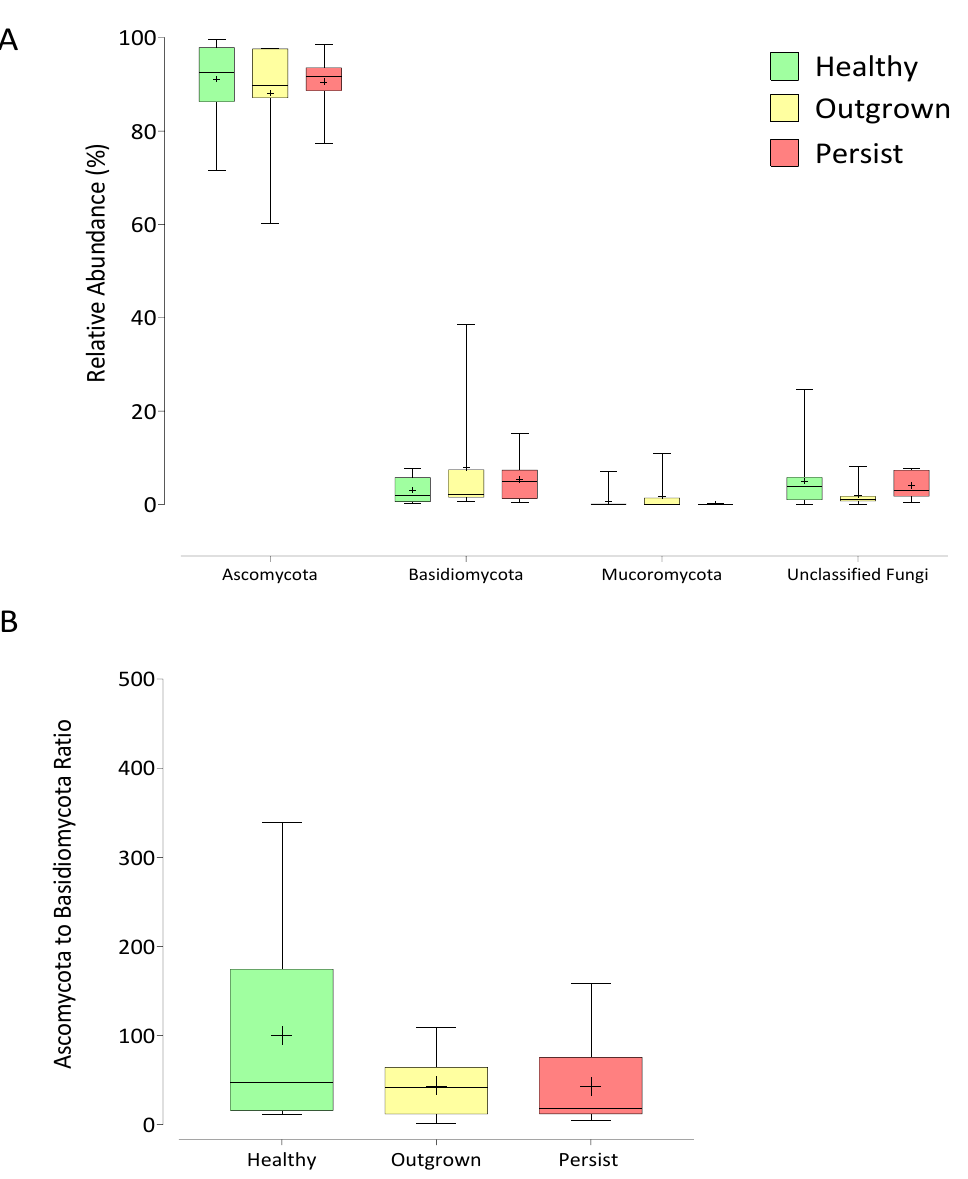
Figure 2. Gut mycobiome of healthy infants and infants with atopic dermatitis. Box and whisker plots depict fungal diversity classification at phylum level ( A ) and the ratio of Ascomycota to Basidiomycota phyla in each group of infants ( B ). The horizontal line represents median value, while the ‘+’ represents mean value. There was no statistically significant difference between the three groups ( p > 0.05).